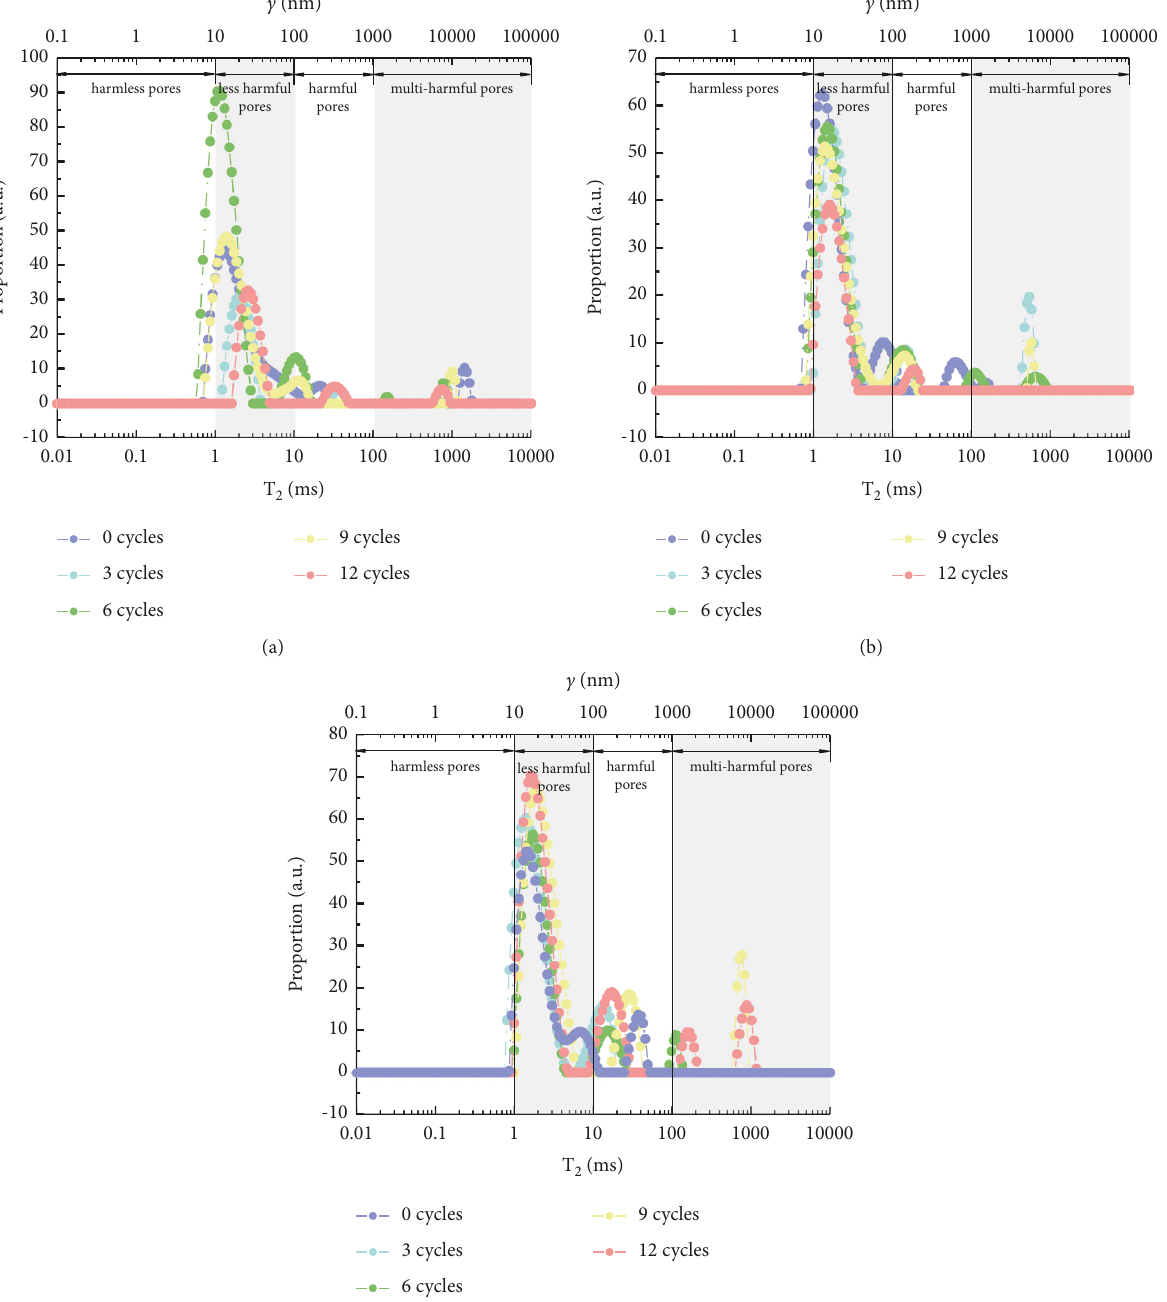
Figure 8: Pore distribution characteristics of semirigid base material after different cycles at different temperature intervals. (a) 20 ° C ∼ 60 ° C. 30 ° C. (c) 20 ° C ∼ 20 ° (b) 5 ° C ∼ − − −